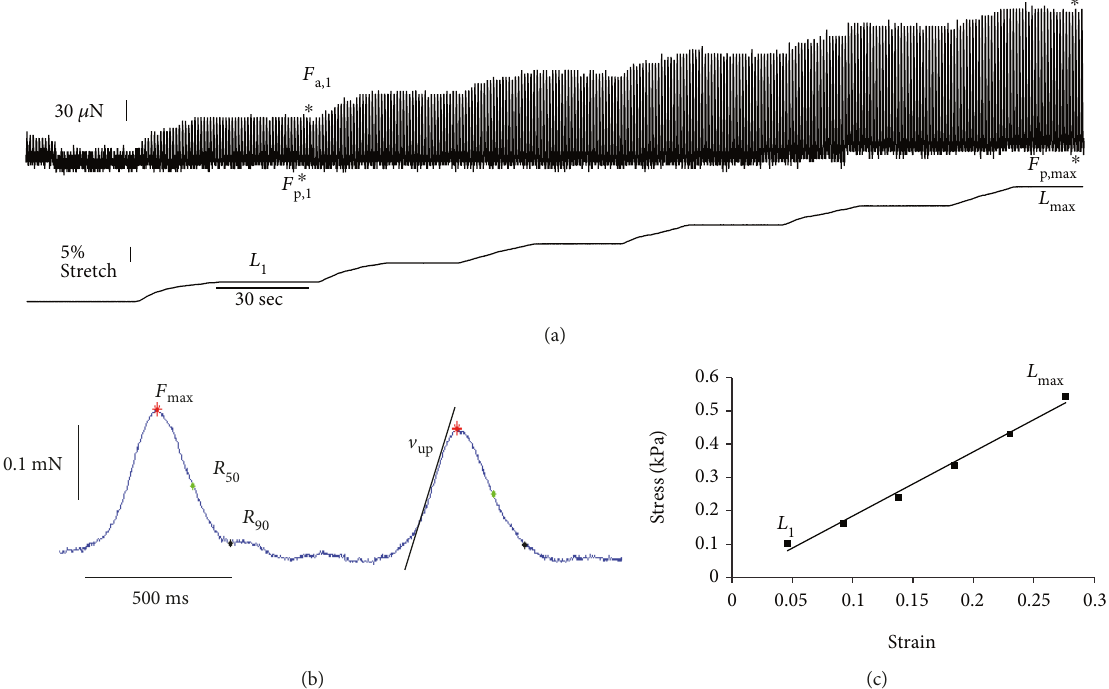
Figure 2: Engineered muscle displays robust twitch contractions. (a) Force (top) and length (bottom) trace of an ECT stretched to 130% of its initial length in 5% steps with individual twitch contractions recorded at each length. Active and passive force are indicated at 5% stretch (length step L ) as F and F and at 30% stretch ( L ) as F and F as indicated by asterisks. (b) Traces of individual 1 a,1 p,1 max a,max p,max , red asterisk), time to 50% and 90% force relaxation ( R contractions were processed to identify maximal twitch stress ( σ a,max asterisk, and R , black asterisk), and peak upstroke velocity ( v ). (c) Young ’ s modulus (sti ff ness) of each tissue was determined by 90 up measuring passive stress, σ , from 5% stretch of initial length ( L =0.05 strain) to 30% stretch ( L =0.30 strain) and calculating the slope p 1 max of the line of best fi t. In this example, Young ’ s modulus =1.93kPa ( R 2 = 0 99